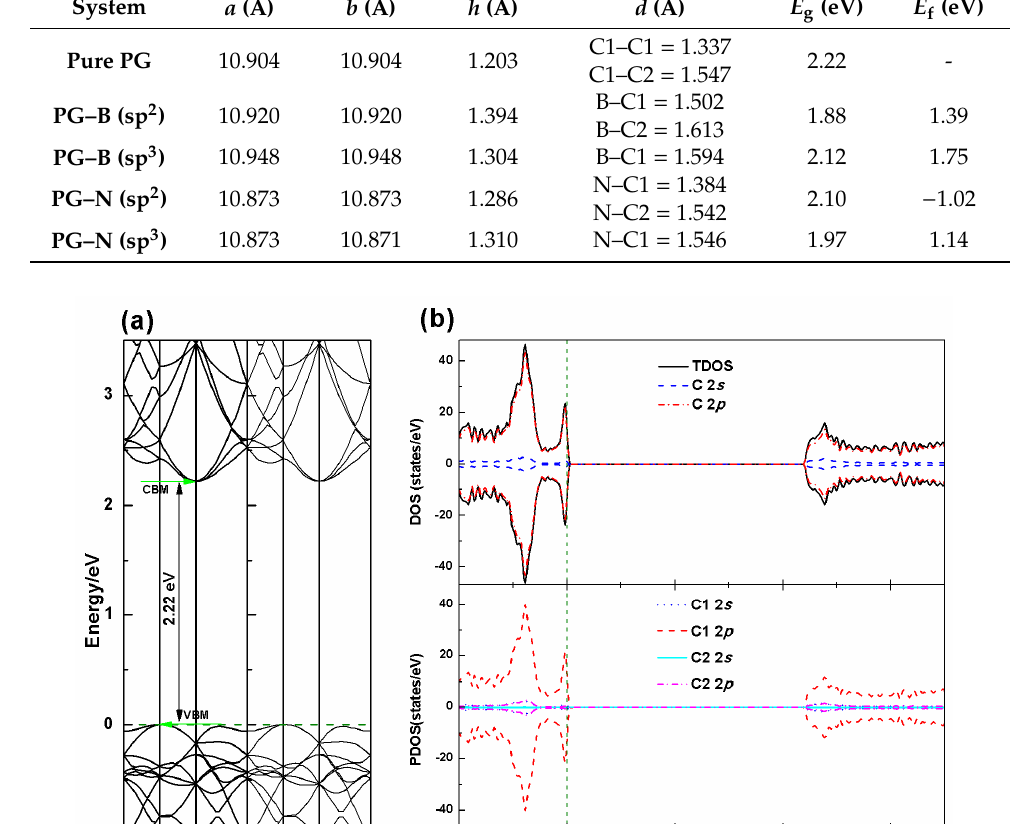
Table 1. Lattice parameters ( a and b in Å), thickness ( h , in Å), lengths of key bonds ( d , in Å), band gap ( E g , in eV), formation energy ( E f , in eV) of the pure PG, PG–B (sp 2 ), PG–B (sp 3 ), PG–N (sp 2 ) and PG–N (sp 3 ) systems.